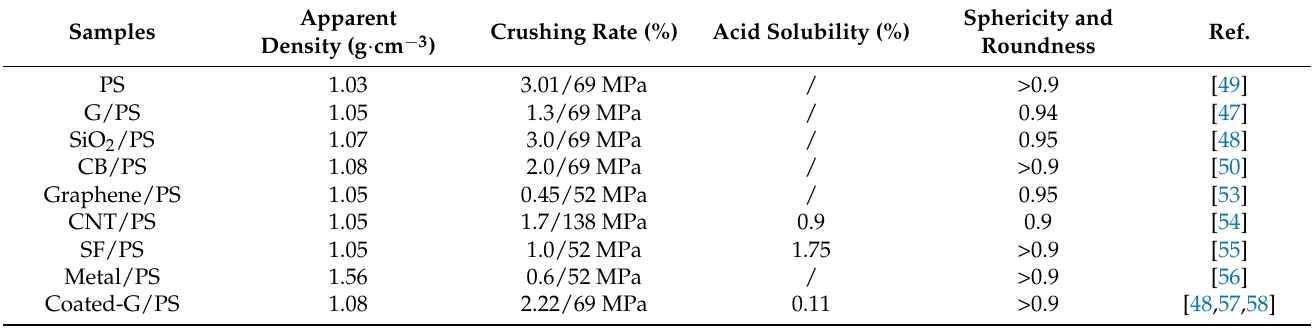
Table 7. Properties of PS based ULDP.